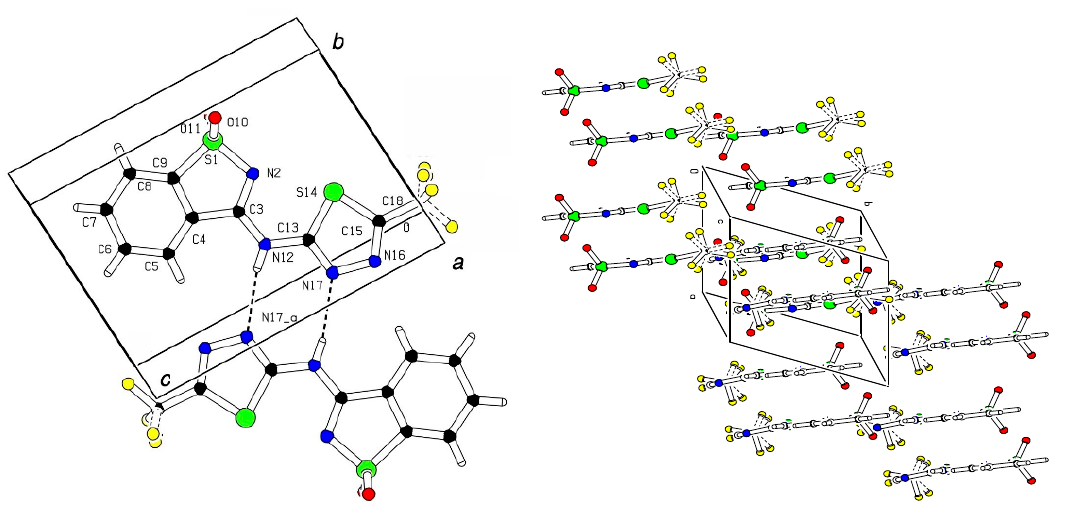
Figure 3. Synthon consisting of a pair of molecules related by an inversion centre strongly hydrogen-bonded via an N—H ···· N interaction ( left panel ) and crystal packing as a stack of parallel layers of molecules ( right panel ).